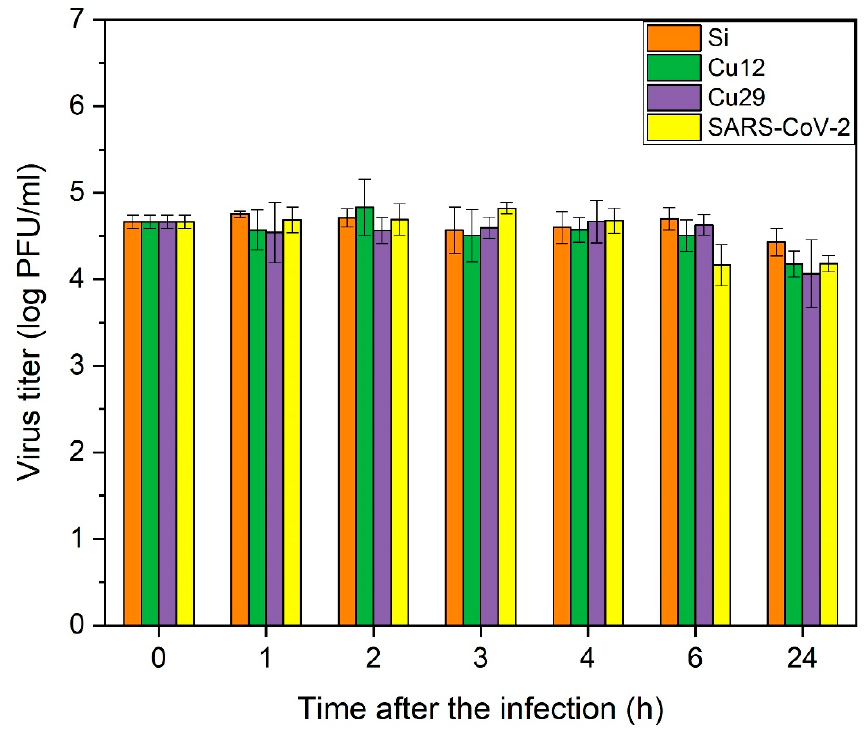
Figure 9. Antiviral effect of Cu12 and Cu29 coatings against SARS-CoV-2. Si was chosen as the negative control, which is shown by orange color.